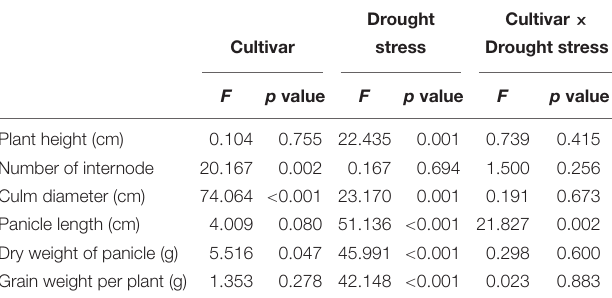
TABLE 1 | Results of two-way ANOVA on the effects of cultivar and drought stress on agronomic traits of broomcorn millet as dependent variables ( n = 3). Drought Cultivar × Cultivar stress Drought stress F p value F p value p value Plant height